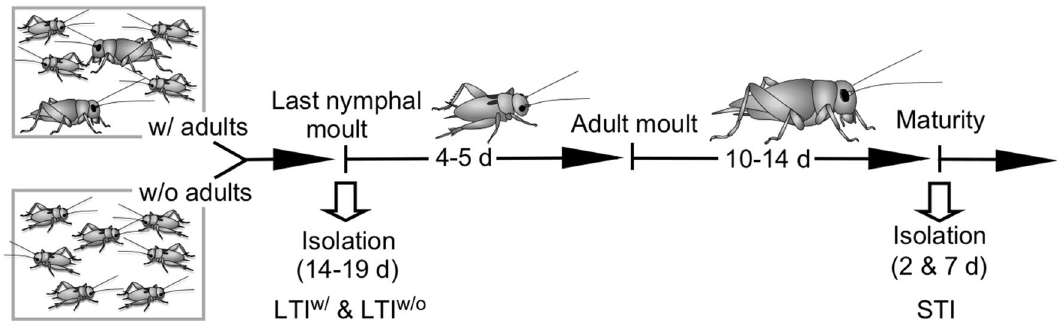
Figure 1. Schema illustrating key events of cricket life history together with culture conditions and periods of social isolation for the different experimental groups of adult male crickets. LTI w/ : long term isolates with prior contact to adult males during nymphal life, LTI w/o : long term isolates without prior contact to adult males during nymphal life, STI : short term isolates, separated at maturity for 2 or 7 days. All components of the figures were created with canvas DRAW 5 for MAC (Version 5.0.2, ACD Systems, https:// www. acdsy stems. com/